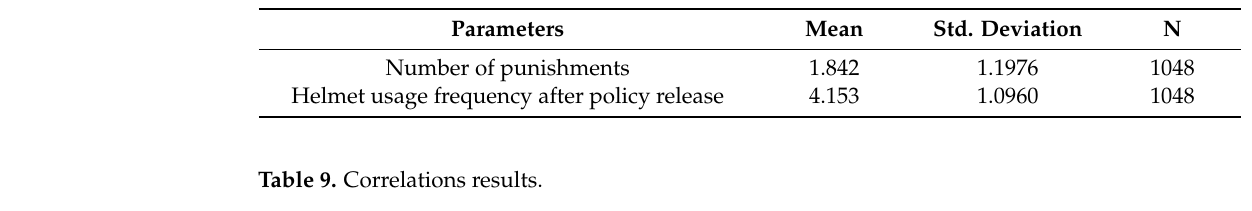
Table 8. Descriptive statistics results.